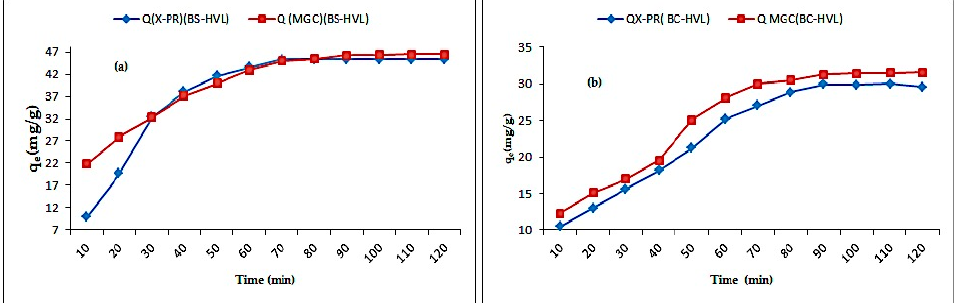
Figure 14. Effect of contact time on the adsorption of the two dyes X-PR and MGC by BS-HVL ( a ) and BC-HVL ( b ) (T = 21 ± 1 °C; mad = 50 mg; Co = 50 mg L − 1 ; stirring speed 150 rpm and pH = 7 ± 0.3).